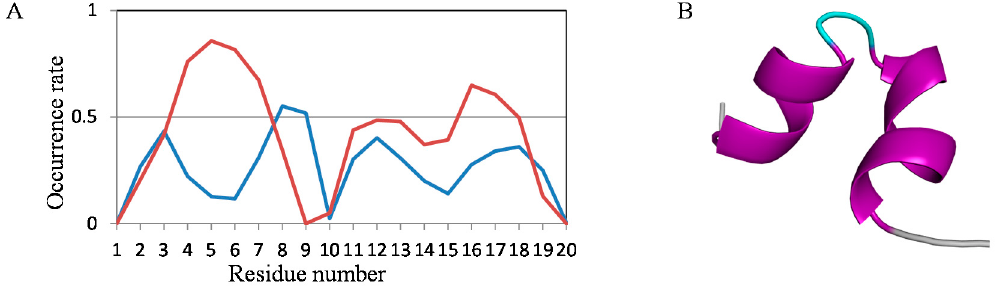
Figure 9. The structure prediction of [GADV]-protein. ( A ) The occurrence rates of secondary structures. Color coding of lines is the same as that in Figure 3; ( B ) The final predicted structure formed at 100 ns. Purple shows helix and light blue shows loop.